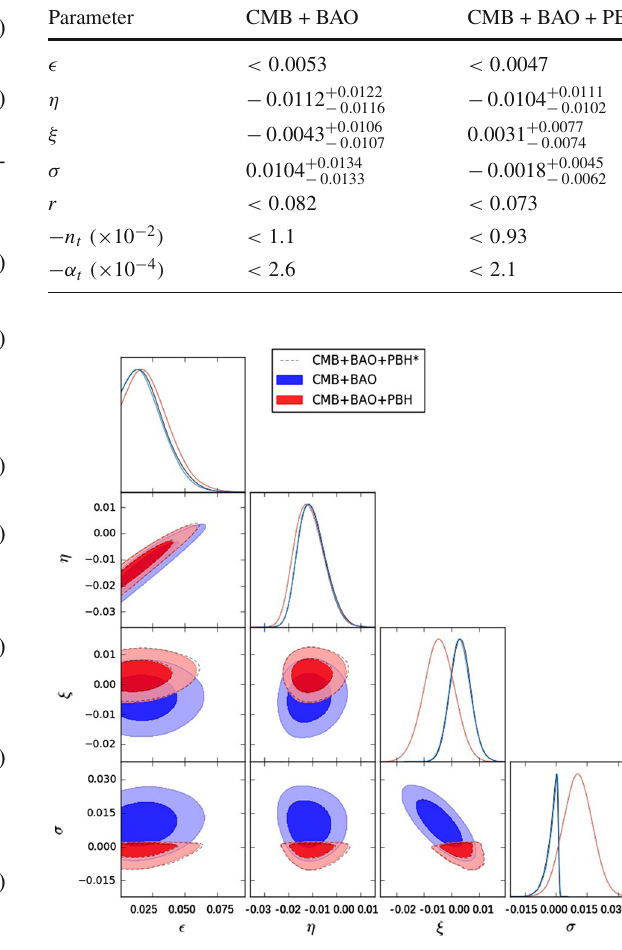
Here the nine parameters sampled in the CosmoMC are , A , (cid:12), η, ξ, σ } , and then n α β { (cid:8) 2 , (cid:8) 2 , τ, θ b h c h s s , s , s , r , MC n t and α t are all taken as the derived parameters. The con- straints on the slow-roll parameters { (cid:12), η, ξ, σ } and the con- tour plots of these slow-roll parameters are illustrated in Table 2 and Fig. 2. We see that the constraint on the fourth slow-roll parameter σ is improved once the constraint from PBHs is included because the running of running is domi- nated by it in the slow-roll inflation model. Here we also work out the predictions of the slow-roll inflation model constrained by the observational data. The parameters { r , n t , α t } characterizing the tensor power spec- trum can be obtained by adopting the Eqs. (19), (20) and (21). The results are showed in Table 2 and Fig.